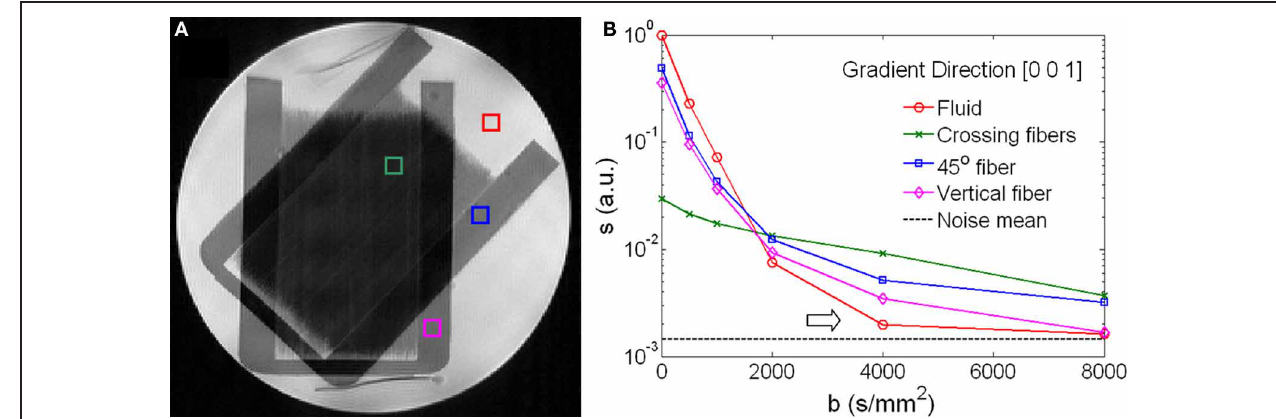
(B) Diffusion-weighted signals as a function of the b -values showed distinctive characteristics for the four voxels highlighted in (A) . In the fluid and the single fiber along the direction of [0, 0, 1], the signals approached the noise floor when b > 2000s/mm 2